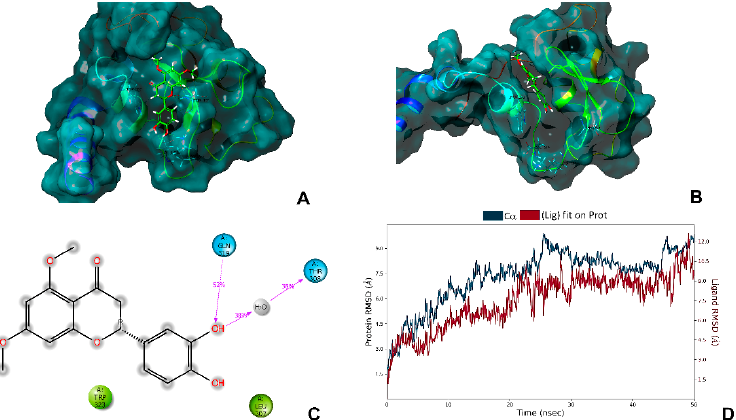
Figure 6. ( A ) Representation of the molecular docking and ( B ) the molecular dynamics complex after 50 ns of Tacotanina with the BIR3 domain of XIAP (pdb5c83). ( C ) Interaction Diagram 2D and ( D ) protein-ligand root mean square deviation trajectory of the atomic positions for ligands (red, Lig fit Prot) and the receptor (blu, C ⍺ positions) of Tacotanina and the BIR-3 domain of XIAP, for the dynamic’s trajectory of 50 ns.